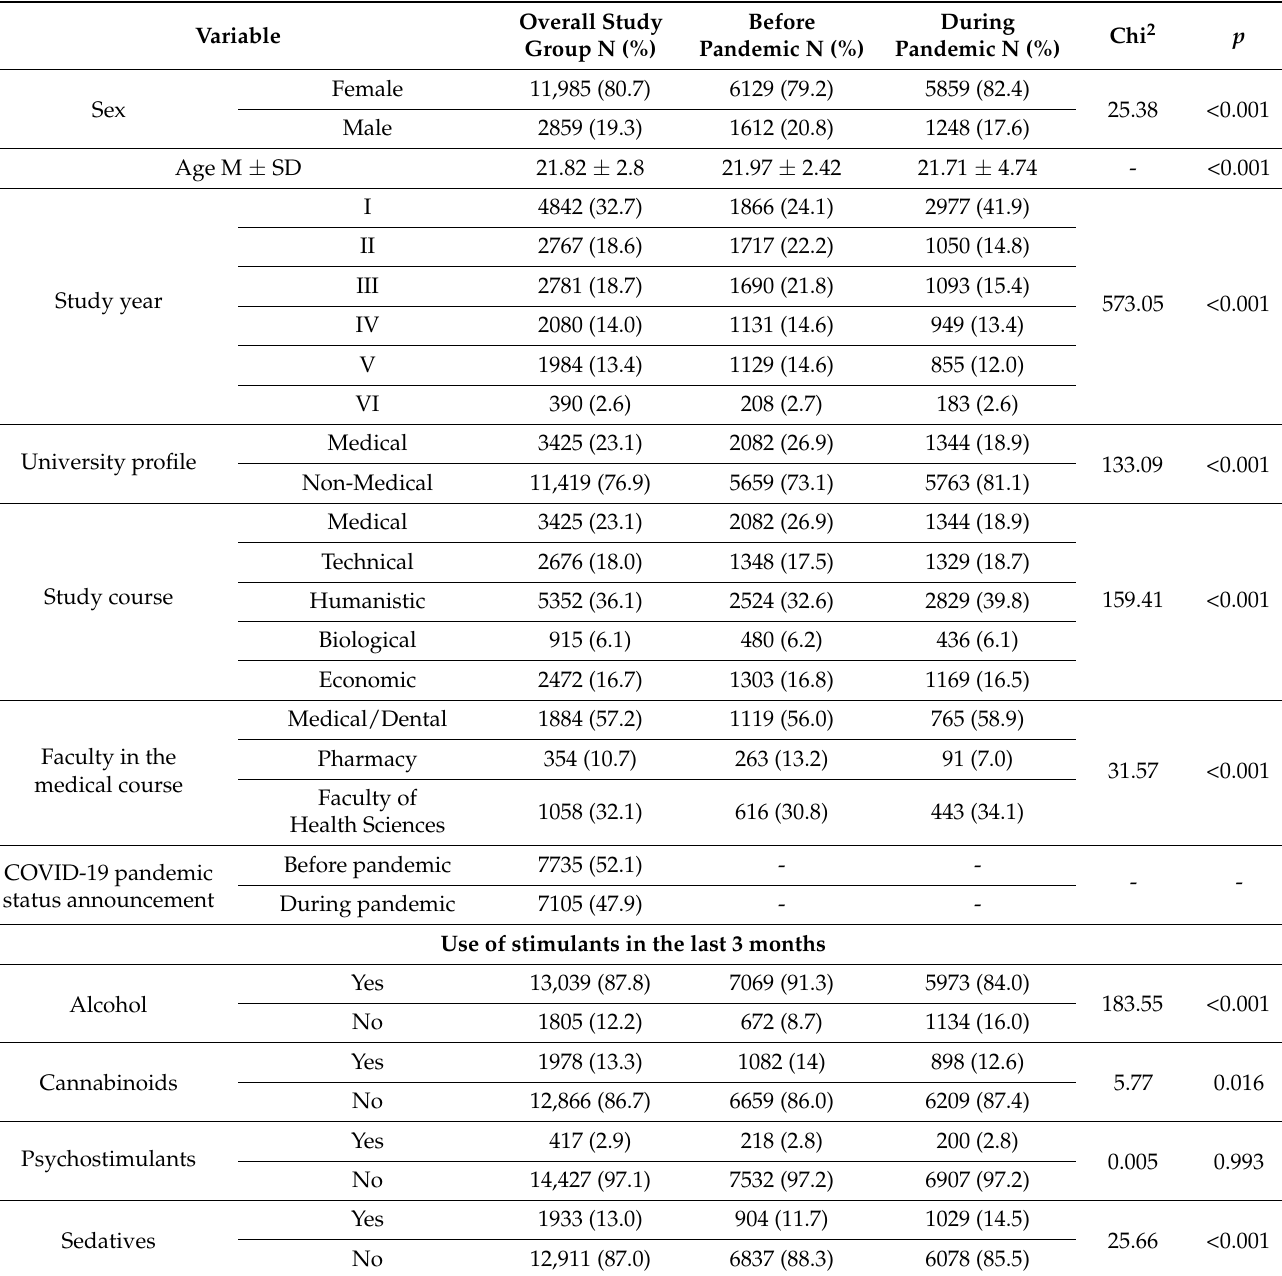
Table 1. Characteristics of the study